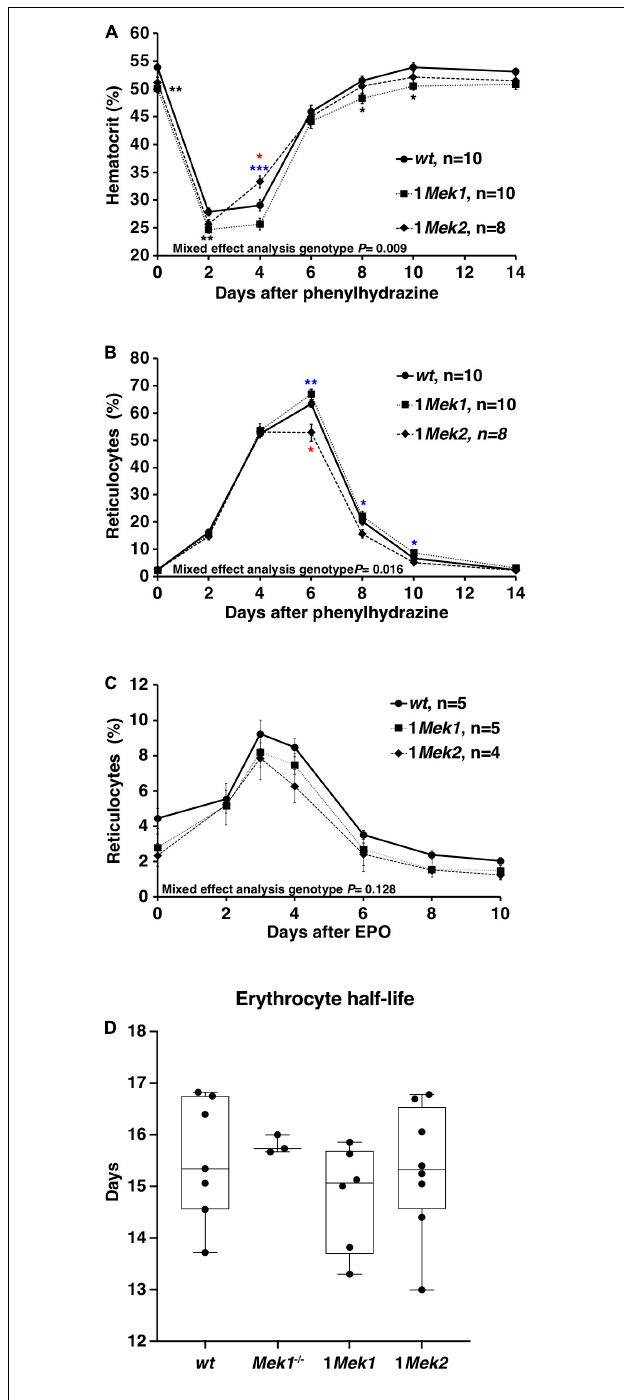
FIGURE 5 | Normal erythropoiesis in 1 Mek1 and 1 Mek2 . (A,B) wt , 1 Mek1 , and 1 Mek2 mutant mice were injected with PHZ on days 0 and 1. Hematocrit (A) and reticulocyte count (B) were assessed every 2 days for 2 weeks. A normal response to this erythropoietic stress was observed in mutants. (C) The effect of a single subcutaneous injection of EPO on reticulocyte counts was monitored in controls and 1 Mek1 and 1 Mek2 mutants. Blood samples were collected every 2 days for reticulocyte count by flow cytometry. Response to EPO was unchanged in mutants. (D) Biotin-reactive agent